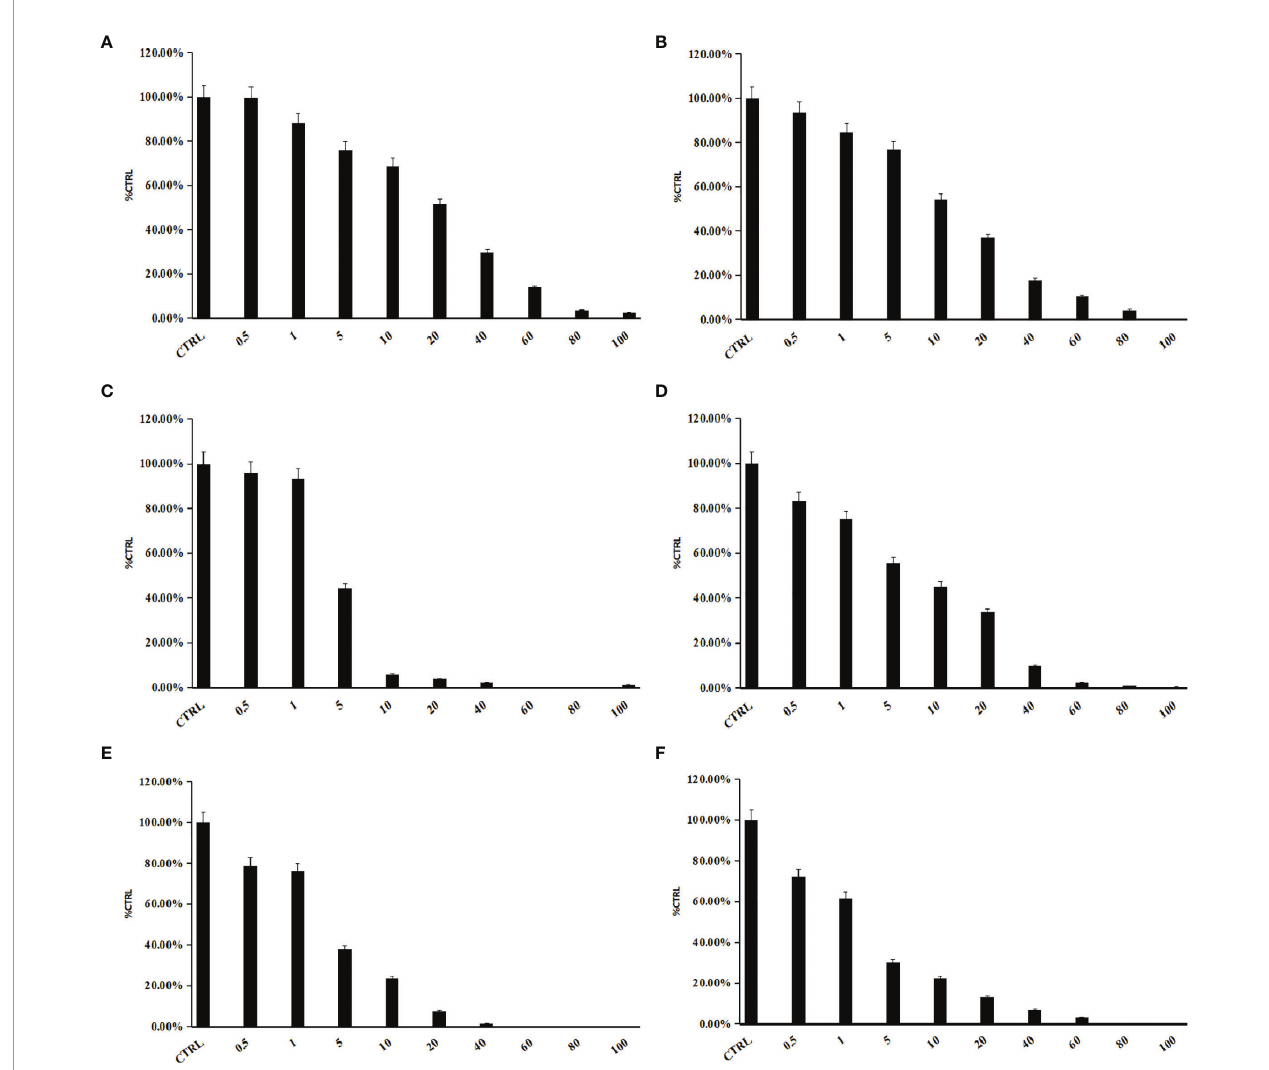
FIGURE 3 | (A) to (C) present concentration-dependent inhibition of MHP towards SULT1A1 (A) , SULT1B1 (B) , and SULT1E1 (C) . (D) to (F) present concentration- dependent inhibition of MOP towards SULT1A1 (D) , SULT1B1 (E) , and SULT1E1 (F) . IC50 was determined by different concentrations of phthalate monoesters. Parallel samples were made, and the average values were used to draw the graph. Data were presented as the mean value plus